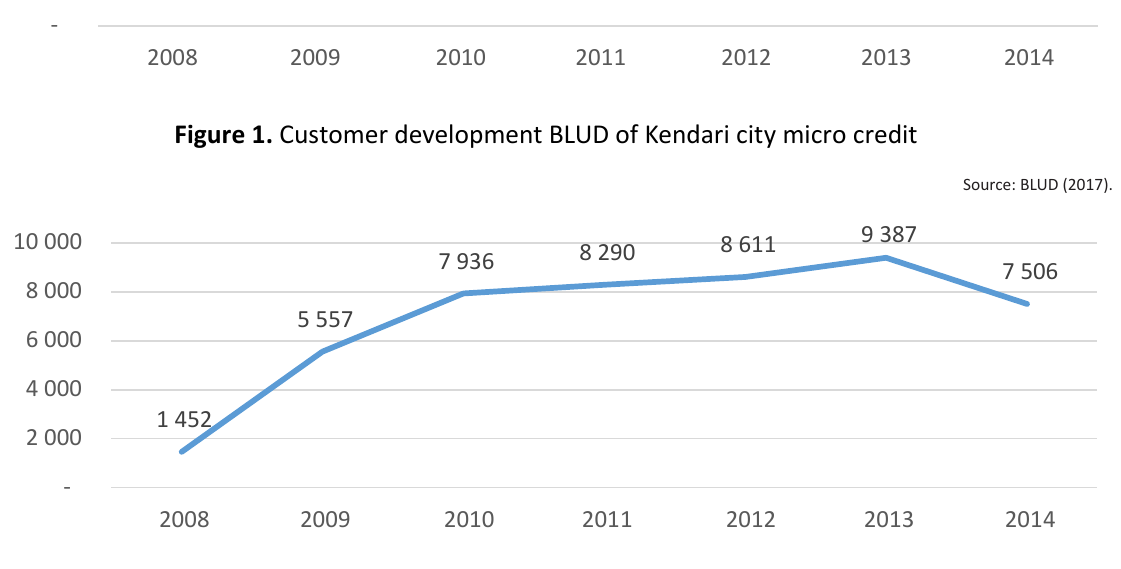
Figure 2. Development of funds distributed (in millions of rupiah)